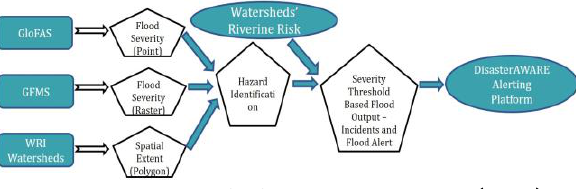
Figure 1. Flowchart for flood model integration